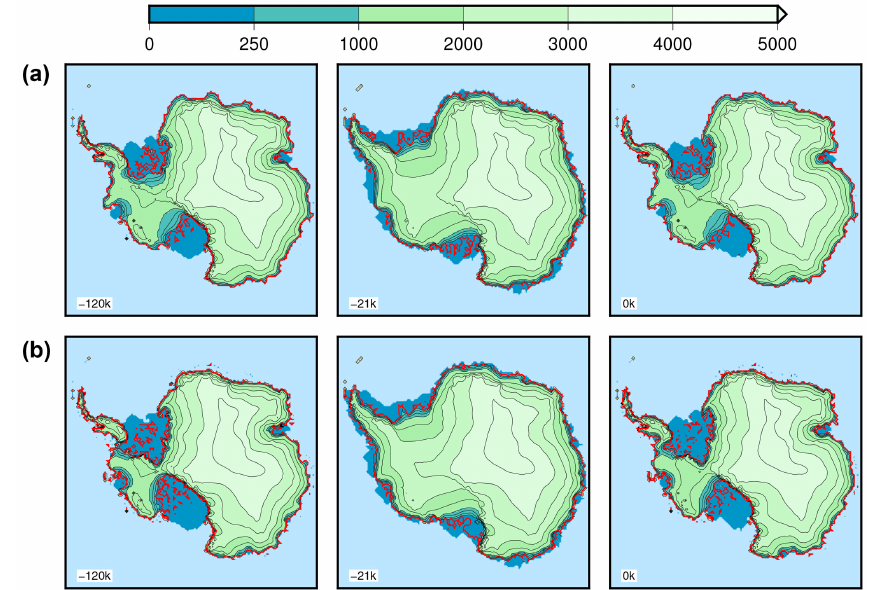
Figure 15. Simulated surface elevation at selected snapshots for the two ensemble members that produce the minimal RMSE at 0kaBP in the transient simulations: AN40S252 (a) and AN40T213 (b) . The ice volume contributing to sea level change from the present is − 9 . 3m (respectively, − 15 . 1m) at 21kaBP for AN40S252 (respectively, AN40T213), whilst it is limited at 120kaBP ( − 0 . 3 and + 0 . 6m). The grounding line is indicated by the thick red line.